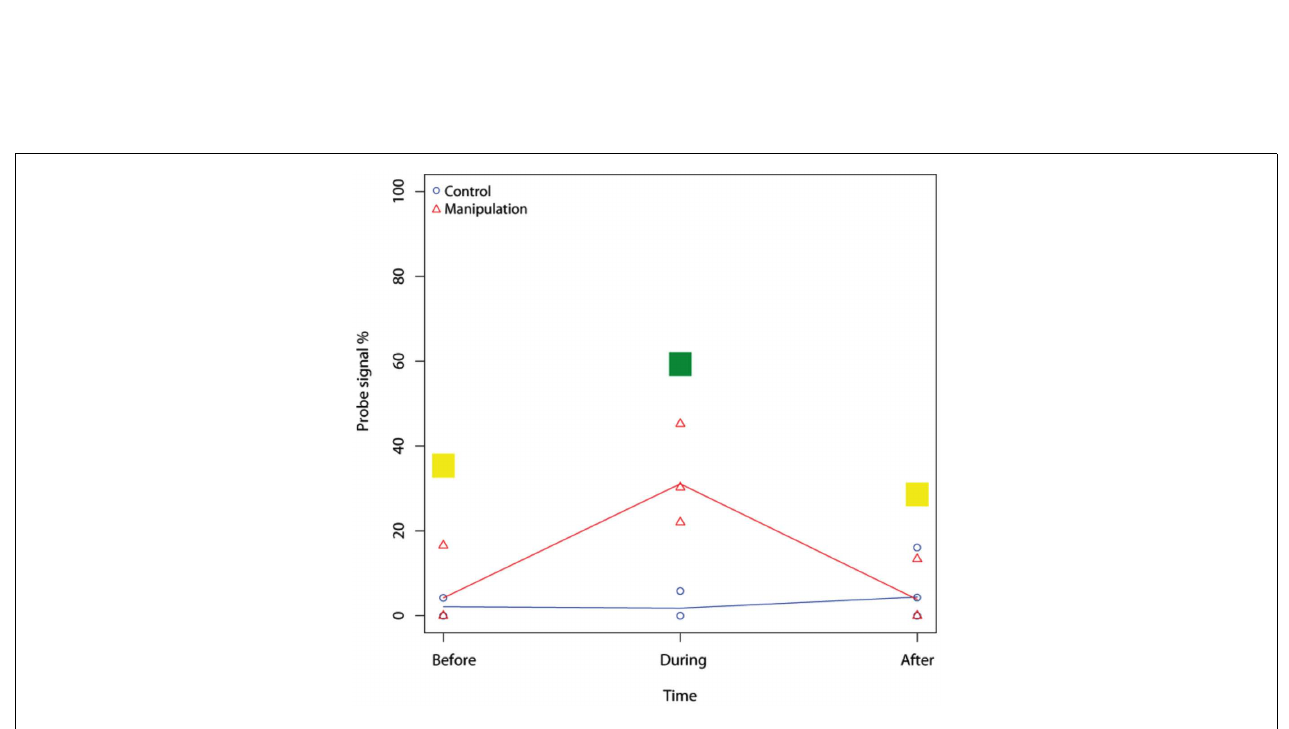
FIGUREA5 | Example of a mixed-effect model result for the microarray probe Mb271 (RNA samples, 2–10cm). Mixed-effect model comparison evaluated the difference between two fitted models, the control and the manipulation model. In Figure 3A, the result of each comparison is shown in color, thus, no effect on studied microarray probe by nitrogen = yellow, stimulated effect = green, inhibited effect = red, and for negative probes = blue.